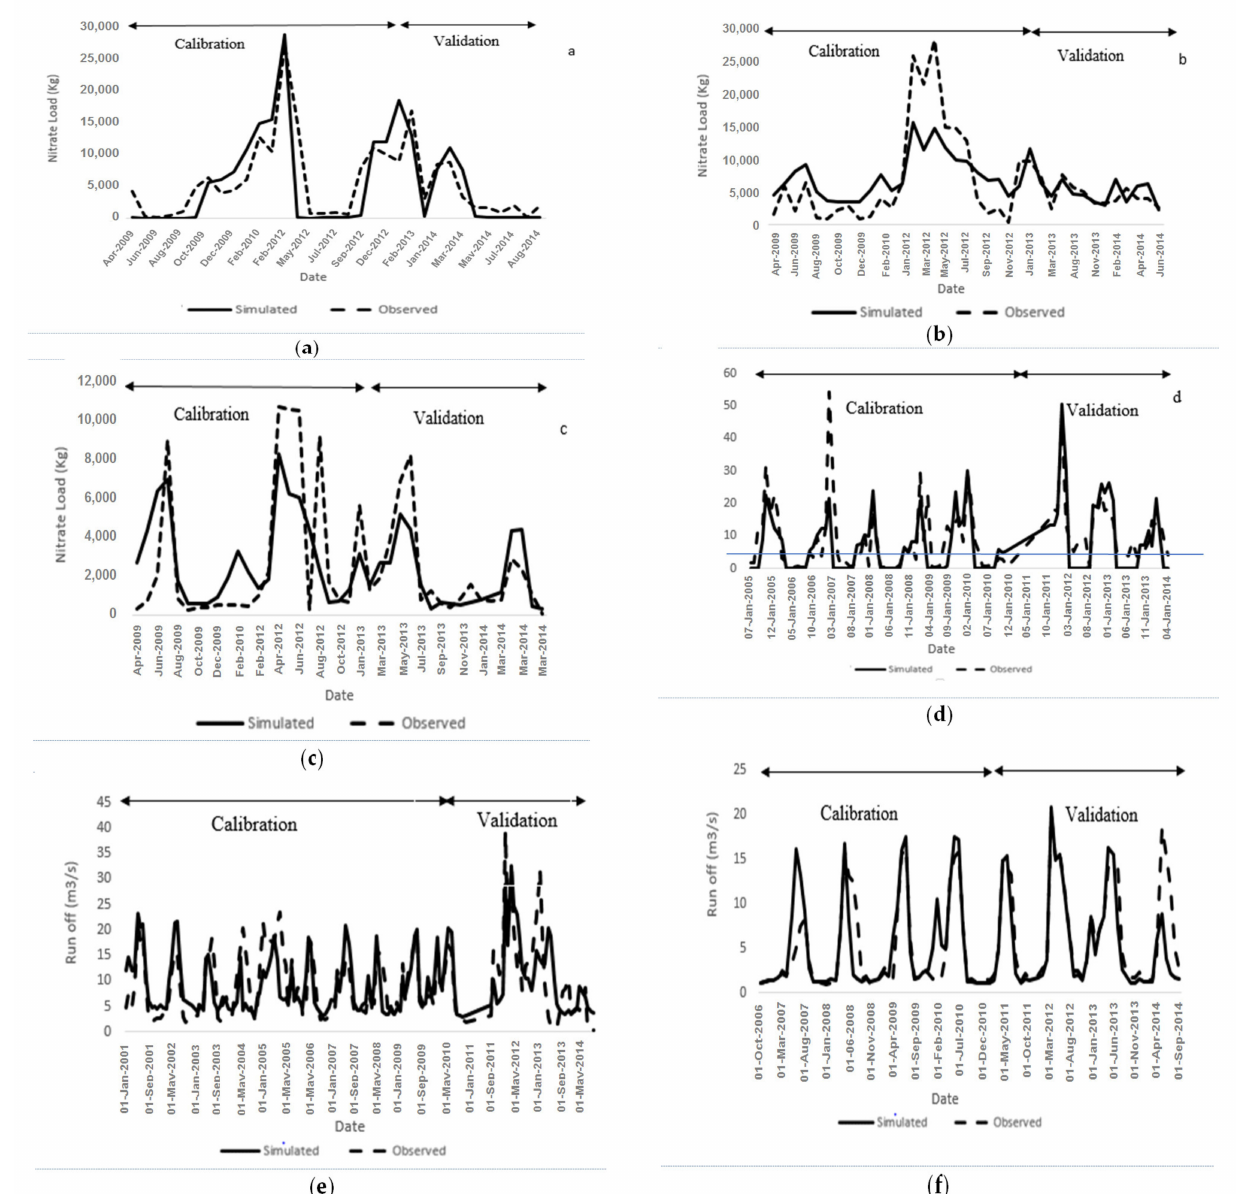
Figure 4. Observed and simulated nitrate during calibration and validation period at Kordkhil ( a ), Rigcheshme ( b ) and Solaiman Tange stations ( c ) and Observed and simulated run off during calibration and validation period at Kordkhil ( d ), Rigcheshme ( e ) and Solaiman Tange ( f